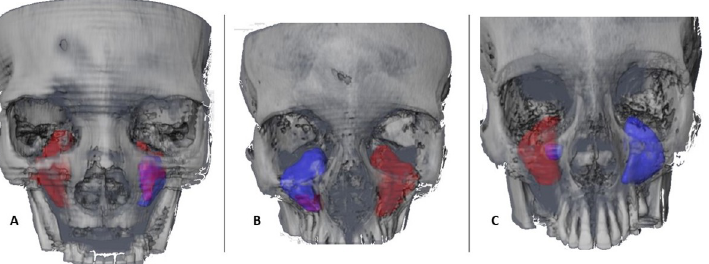
Fig 4. Volumetric images in frontal view. Volumetric images in frontal view of the contour and the sinus occupation of 3 representative cases of the sample. In blue, the complete sinus volume, in red the volume which had been pathologically occupied, in purple the volume of residual superposition. A) CBCT16 Total right volume 119.6 mm 3 , occupied volume 119.6 mm 3 ; total left sinus volume 71.5 mm 3 , occupied volume 24.6 mm 3 . B) CBCT10 total right volume 107.4 mm 3 , occupied volume 16.1 mm 3 ; total left sinus volume 393.8 mm 3 , occupied volume 393.8 mm 3 . C) CBCT8 total right volume 241.7 mm 3 , occupied volume 209.6 mm 3 ; total left volume 111.7 mm 3 , occupied volume 0 mm 3